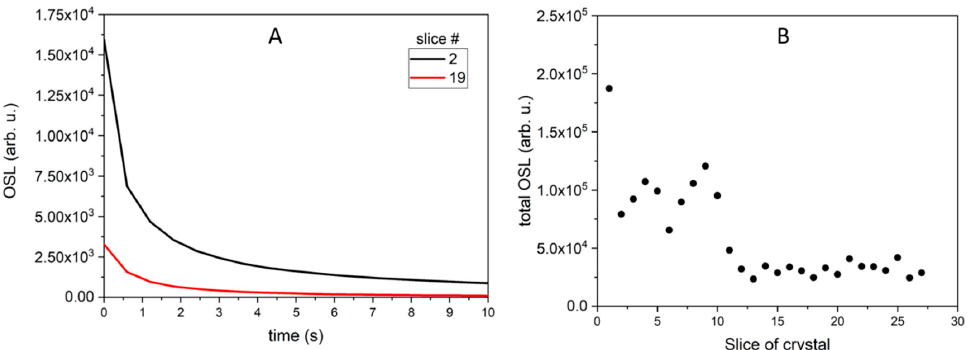
Figure 4. OSL signal of LMP doped with 0.8-mol% Tb. ( A )—OSL decay curves for slices #2 and #19, typical for all slices, differing only in amplitude. ( B )—total OSL signals integrated from 0 to 300 s for all OSL curves. The samples were irradiated with 0.2 Gy of beta rays in the Risø reader. Slice of crystal—the numbers represent labelling of samples along the crystal length, as illustrated in Figure 1.